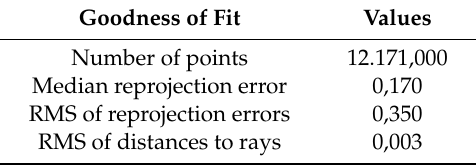
Table 1. Statistical results of data collection obtained after the aerotriangulation process